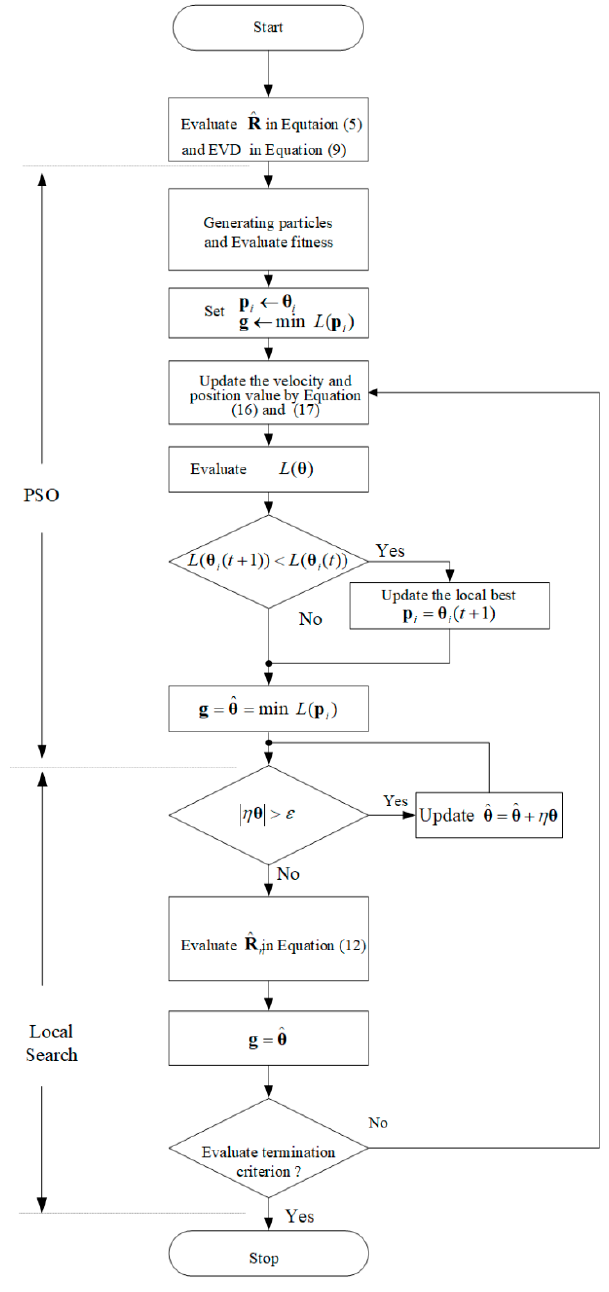
Figure 1. The flowchart of the proposed method.